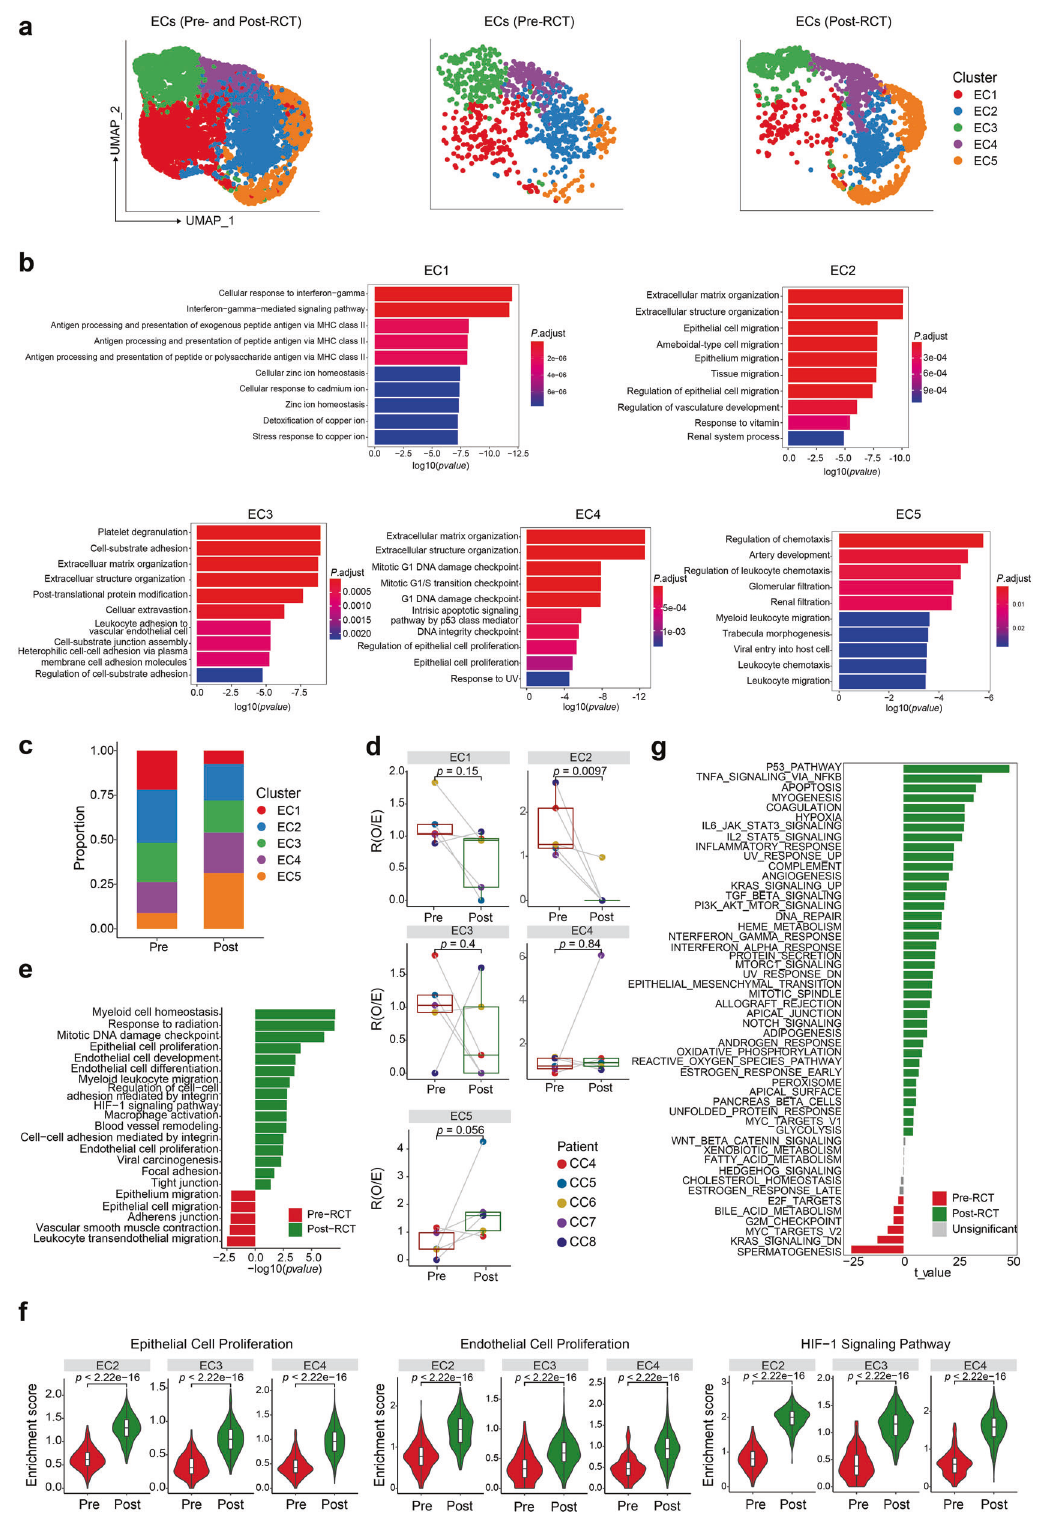
Fig. 6 RCT enhances angiogenic, hypoxic, and in fl ammatory features of endothelial cells. a UMAP visualization of 5 EC subclusters in all (left panel), pre-RCT (middle panel), and post-RCT samples (right panel). b GO term analyses of EC subclusters. c Bar plots showing the relative proportions of 5 EC subclusters in all EC in pre- and post-RCT samples. d Box plots showing the fold change in the abundance of each EC subcluster compared between pre- and post-RCT samples. The colors of dots and squares represent patients and sample groups, respectively. The p values correspond to paired Wilcoxon tests. e The enriched GO terms and KEGG pathways of ECs in pre-RCT versus post-RCT samples. f Violin plots showing the indicated pathway enrichment of EC2-4 cells between pre- and post-RCT groups (two-sided Wilcoxon test). g GSVA analysis of hallmark pathways of ECs in pre-RCT versus post-RCT samples